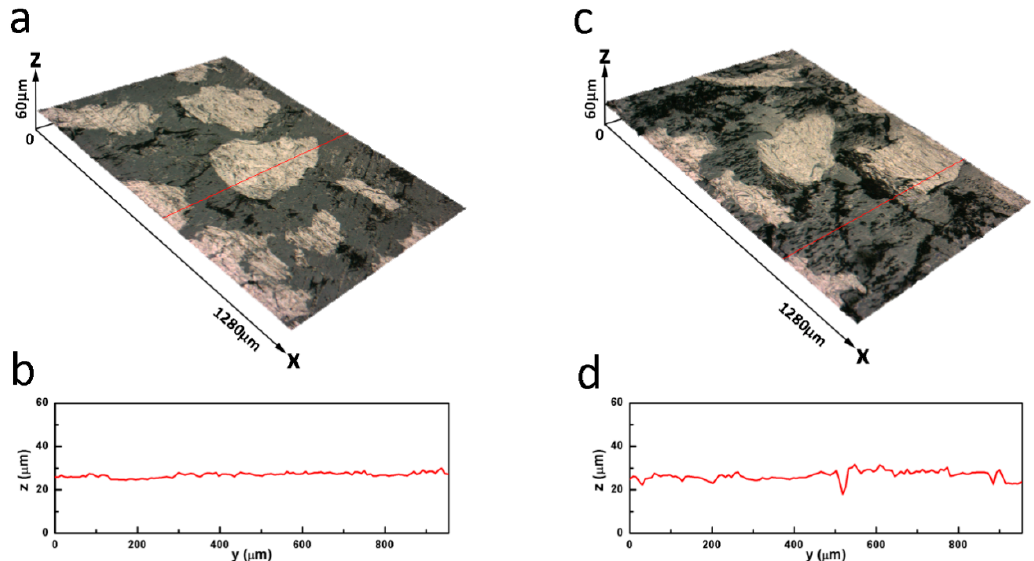
Figure 5. 3-D Images of friction surface of the Gr–PF friction composite with different speeds at 0.23 MPa: ( a ) 15.7 m/s, ( b ) profile lines of ( a ), ( c ) 47.1 m/s, ( d ) profile lines of ( c ).